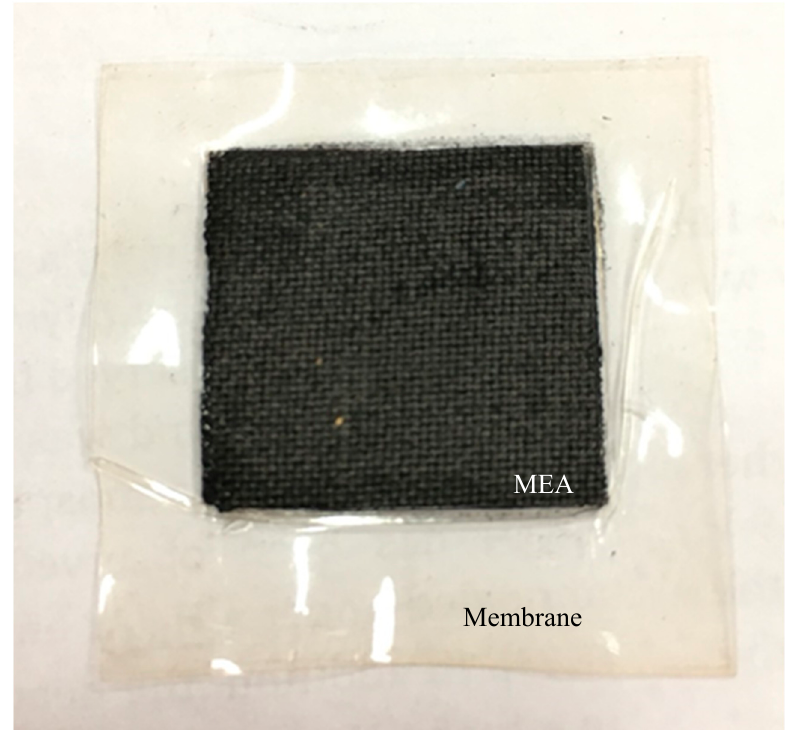
Figure 1. Example of the obtained MEA.